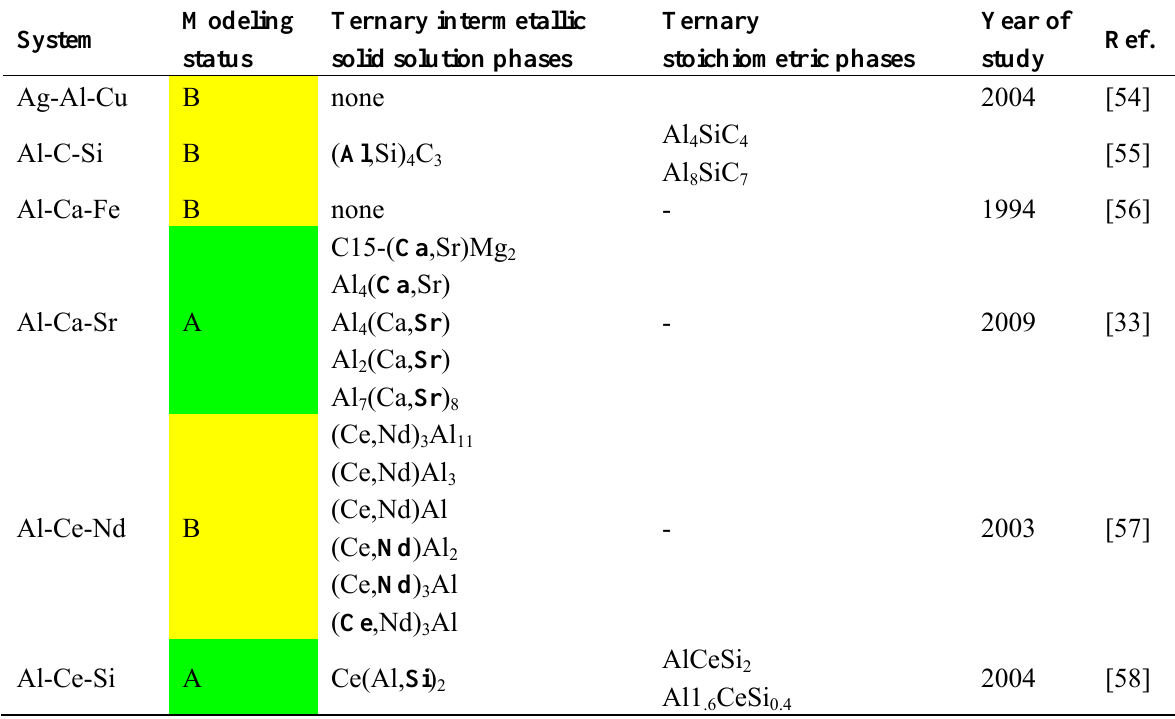
* indicates a true ternary solution phase, which is the same meaning in the Table 3. Table 3. Ternary systems—not containing Mg—with complete thermodynamic descriptions and their classified modeling status. Indication details are the same as in Table